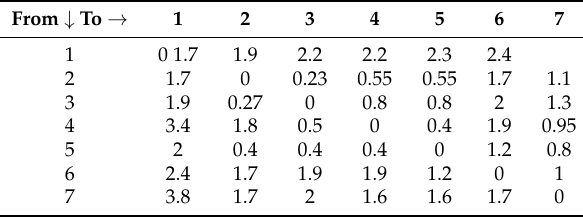
Table A2. Distances of the seven locations in